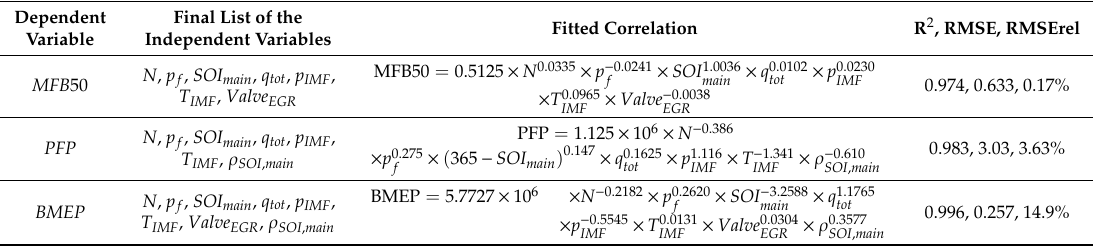
Table 5. Final list of the selected independent variables, and the related correlations, for MFB50, PFP, and BMEP and the corresponding fitting precision.